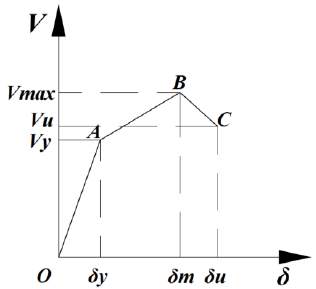
Figure 15. Definition of characteristic points of the skeleton curve.